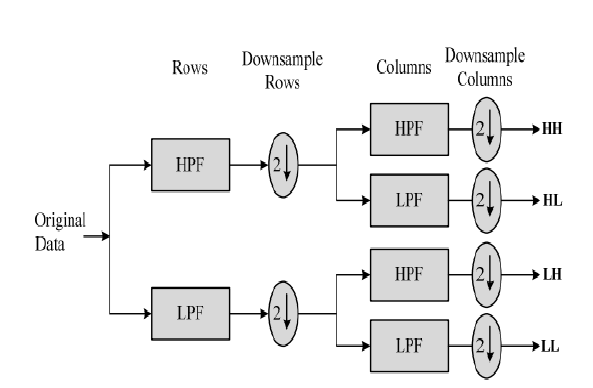
Figure 3. Block diagram of 2D forward DWT